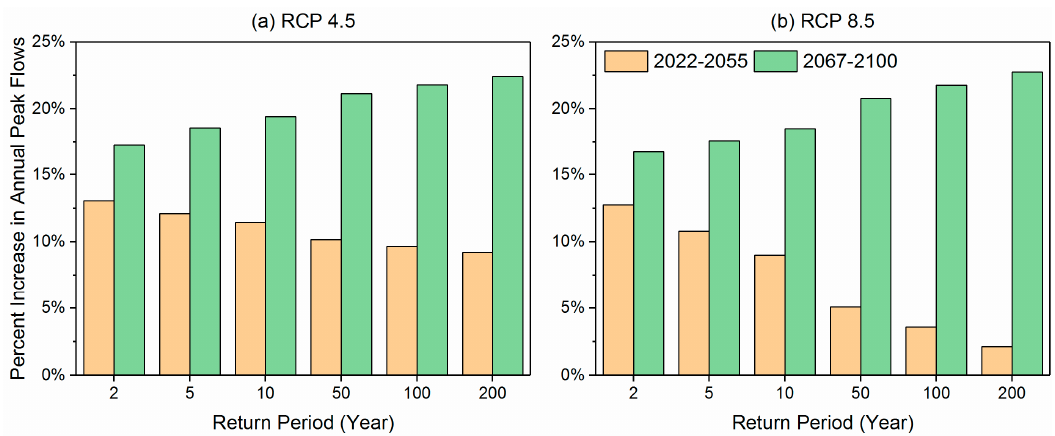
Figure 7. The frequency curves of the annual peak flow at Monroe for USGS instantaneous observations (1964–2014), RCP4.5 ( a ); and RCP8.5 ( b ) made by the Bulletin 17C method.